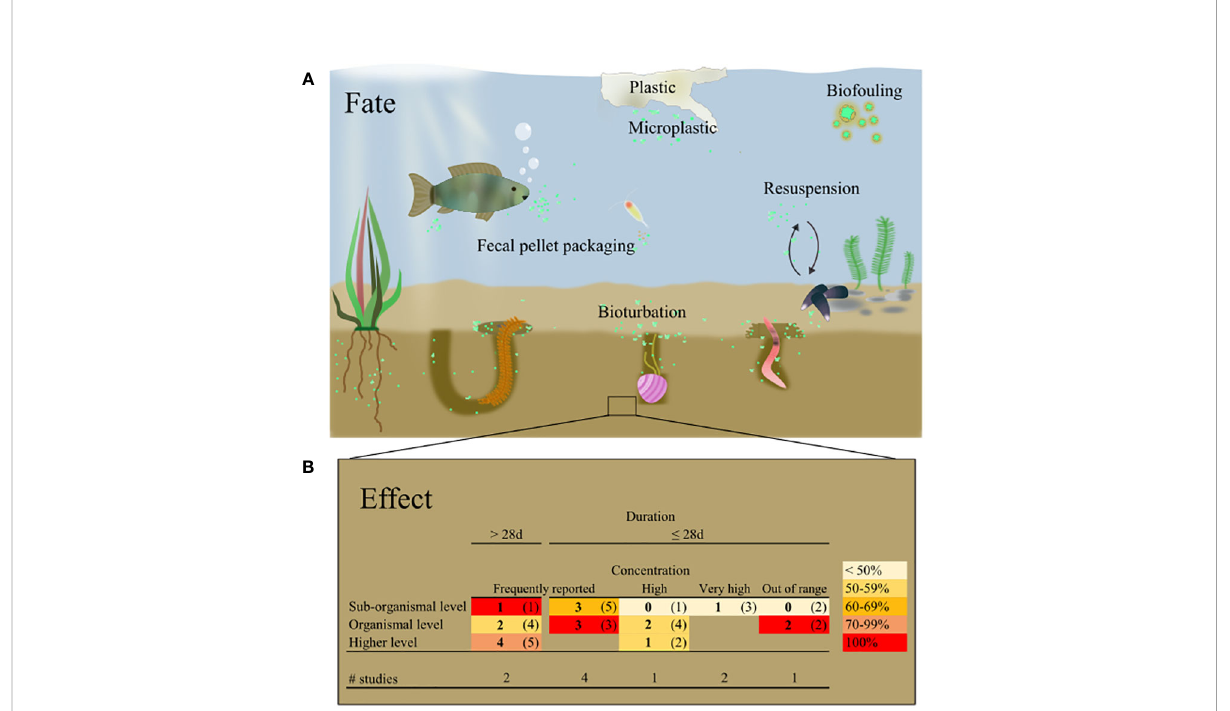
FIGURE 1 General fate processes (A) and occurrence of effects (bold numbers) and effects tested (numbers in brackets), based on 10 effect studies of sediment-associated MPs (B) (Besseling et al., 2013; Wright et al., 2013; Van Cauwenberghe et al., 2015a; Green et al., 2016; Bour et al., 2018; Gomiero et al., 2018; Leung et al., 2018; Hope et al., 2020; Urban-Malinga et al., 2021; Urban-Malinga et al., 2022). Each endpoint studied in a speci fi c experimental condition ( i.e. , combination of concentration, duration, polymer type) was counted as one observation, and for each observation we recorded whether a signi fi cant effect was reported at the lowest observed effect concentration (LOEC). If no effects were observed, the highest concentration included in the study, i.e., the no observed effect concentration (NOEC), was reported. Endpoints are grouped according to level of biological organization ( i.e. , sub-organismal, organismal and higher level of biological organization). Exposure durations were divided as >28 days and ≤ 28 days. Based on fi eld concentrations reported in the literature, studied MP concentrations was sorted as “ most frequently reported ranges and lower ” for concentrations ranging 0.0001-0.08 mg MPs/kg sediment (Van Cauwenberghe et al., 2015b; VKM et al., 2019; Deng et al., 2021) “ high concentrations ” reported from known contamination hot-spots (Carson et al., 2011) ranging 0.1-0.7 mg MPs/kg sediment, “ very high concentrations ” for concentrations that has been reported once ranging 1-7 mg MPs/kg sediment (Haave et al., 2019) and “ out of range ” when exceeding highest reported concentrations, which is above 200,000